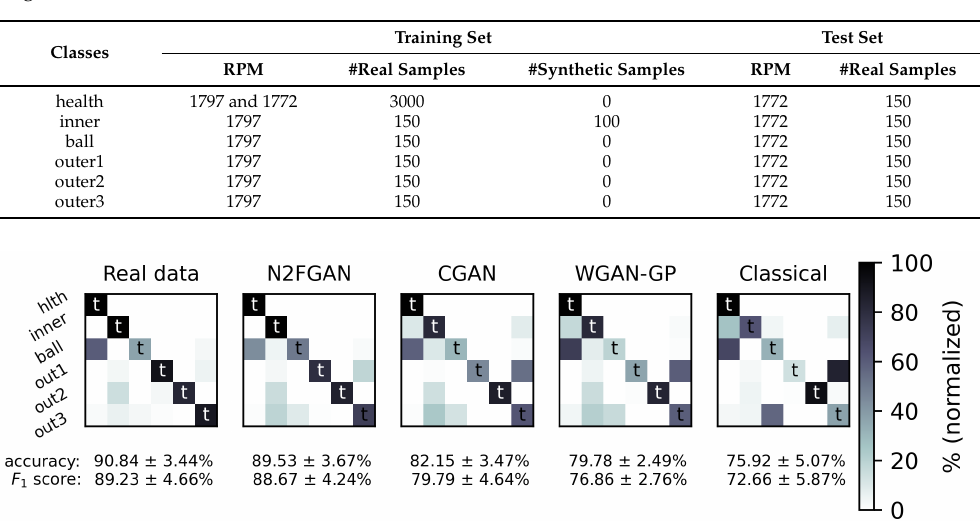
Figure 10. Comparing the effect of each augmentation framework on the classifier performance when the inner class is augmented; t stands for true labeled